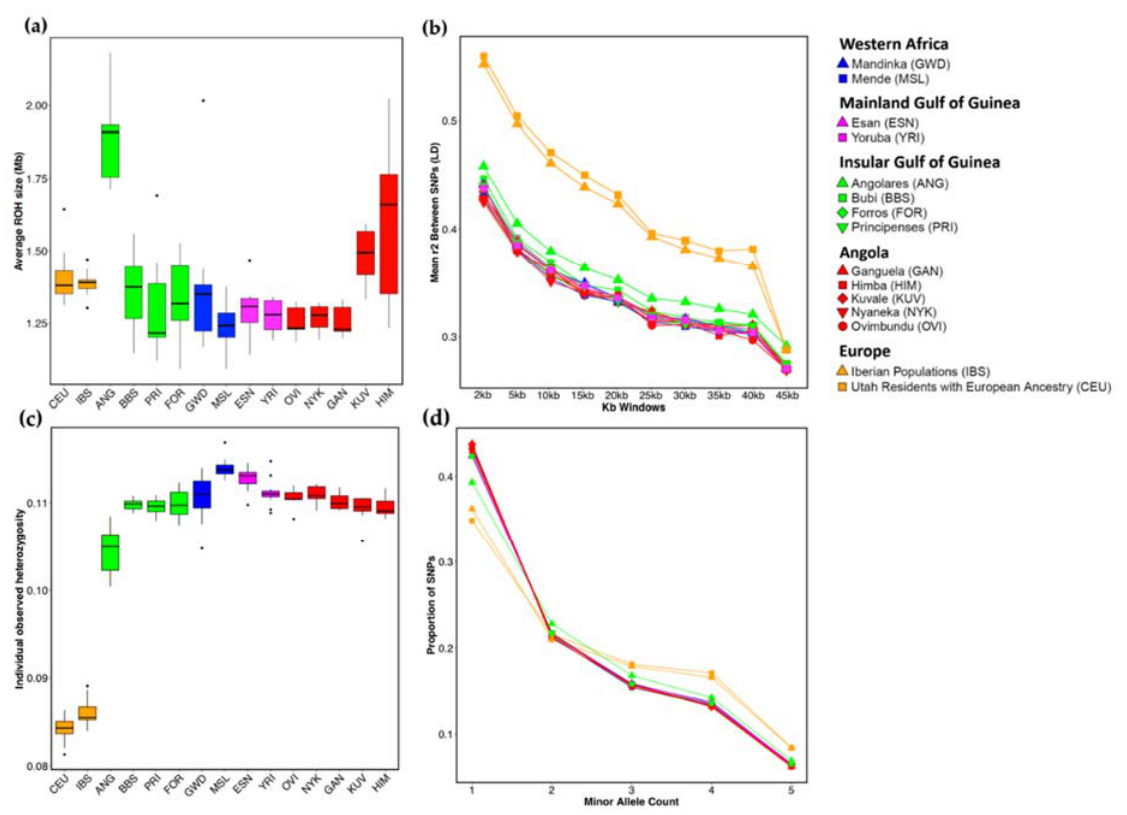
Figure 3. Summary statistics of genetic diversity. ( a ) Boxplots representing the individual variation in the average size of runs of homozygosity (ROH), defined as the ratio between the total length of ROH (sROH) and the number of ROH (nROH). ( b ) Linkage disequilibrium (LD) decay with physical distance. ( c ) Boxplots representing the variation in individual observed heterozygosity per locus (Ho). ( d ) Site frequency spectra (SFS). For ( b , d ), populations were randomly downsampled (without replacement) to the smallest sample size, and the average over replicates is reported.